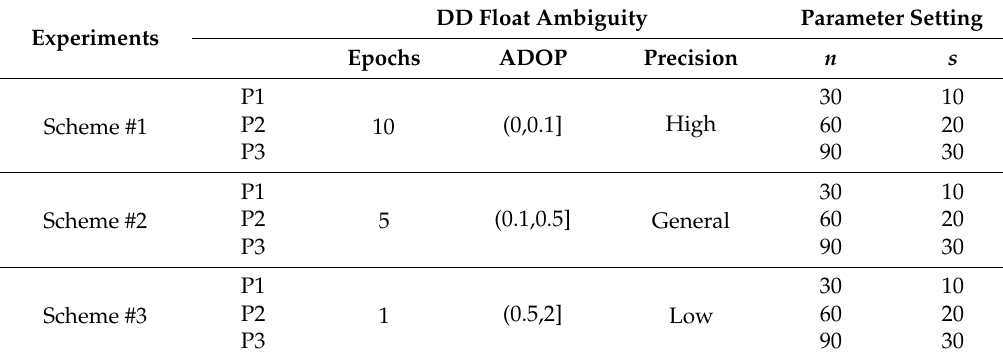
Table 2. Experimental design with various precision double differenced float ambiguities and parameter setting. DD: double differenced; ADOP: ambiguity dilution of precision.